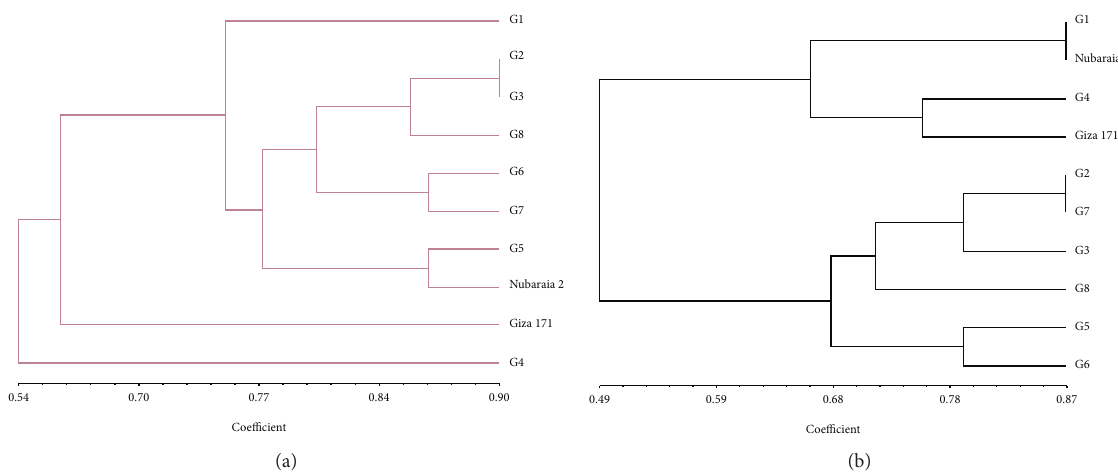
Figure 3: Dendrogram of the 10 wheat genotypes using the UPGMA method based on ISSR (a) and SCoT (b).